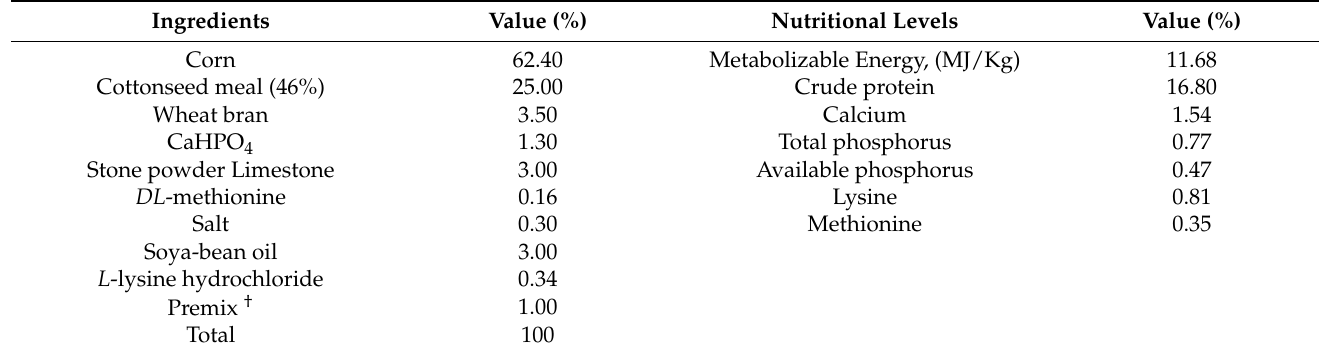
Table 1. Composition and nutrient levels of the experimental diets (air-dry